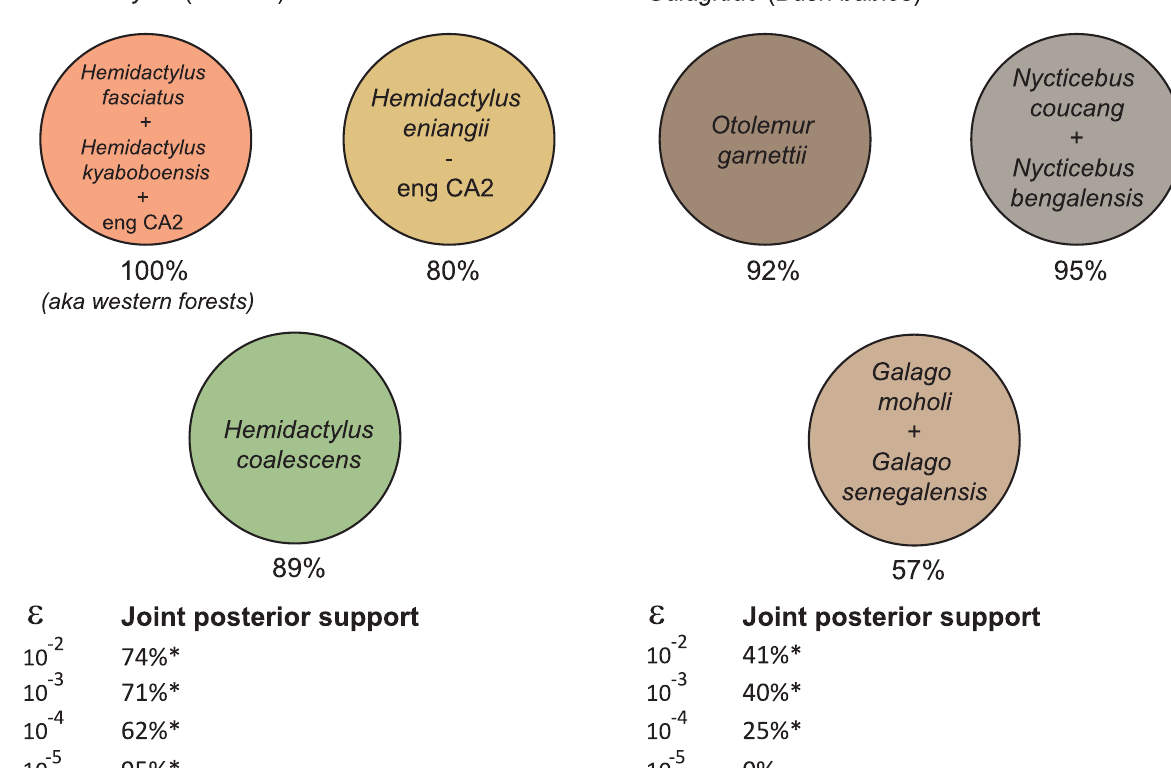
using StarBeast3 . The Galagidae , commonly known as the bush babies, and the Lorisidae are closely related families of small nocturnal primates 34 . Due to their nocturnal habits, bush babies